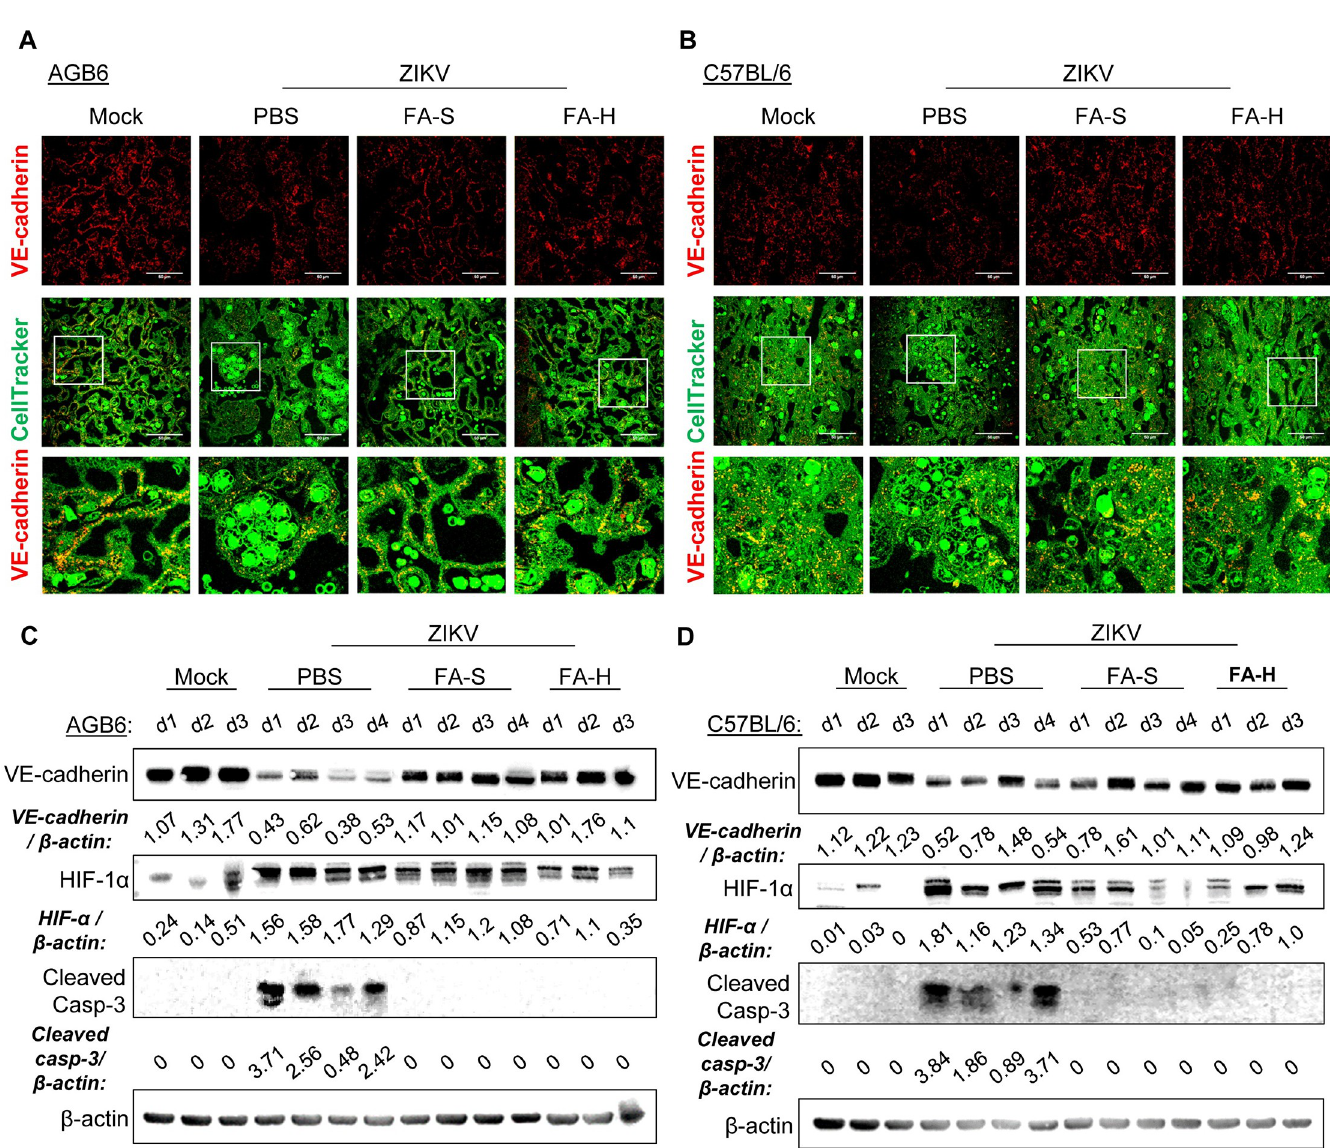
Fig 6. FA limits ZIKV replication and alleviates ZIKV-induced inflammatory response in the placenta. ( A-B) ZIKV burden in the placenta of AGB6 (A, E15.5) and IFNAR1 antibody-treated C57BL/6 (B, E13.5) mice. Western blot analysis of protein level of ZIKV-NS3. (C-D) Infiltration of leukocyte in the placenta of AGB6 (C) and IFNAR1 antibody-treated C57BL/6 (D) mice. Representative confocal images of placental sections immunostained for CD45 (blue, upper panels), IL-1 β (blue, lower panels), and CellTracker for cytoplasm (green). (E-F) Western blot analysis of protein levels of inflammatory cytokines in the placenta of AGB6 (E) and IFNAR1 antibody-treated C57BL/6 (F) mice, β -actin for loading control. Density ratios of respective protein and β -actin are shown in Western blot. Samples are pooled placental tissue lysates of 3–4 representative pregnant mice (d1-d4). � P < 0.05 and �� P < 0.01 by Kruskal-Wallis, Bonferroni post-hoc test.